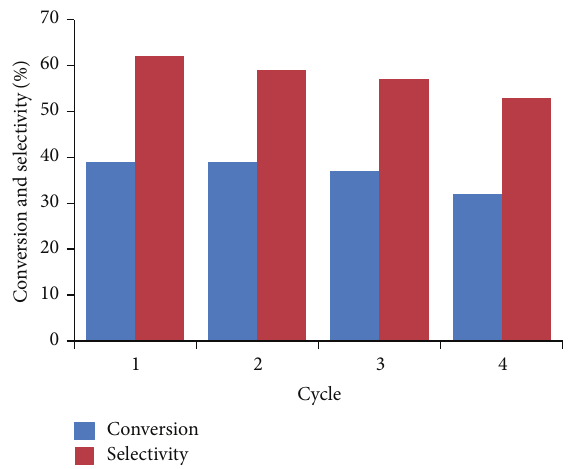
Figure 5: Stability test for 3.5 wt% Pt/CNTs shown as perfor- mance versus number of recycling runs. Reaction conditions: 50 mg 3.5 wt% Pt/CNTs, 1.00 g CAL, 30 mL isopropanol, 10 bar H 2 , 60 ∘ C, and 2h.